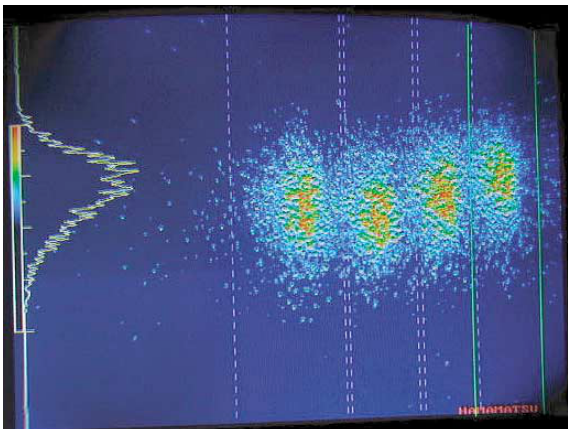
FIG. 15. (Color) A typical streak camera image taken with 326 mA of positrons present in CESR. The second bunch in the train arrives later than the first bunch. This signifies a change in the instability’s oscillation